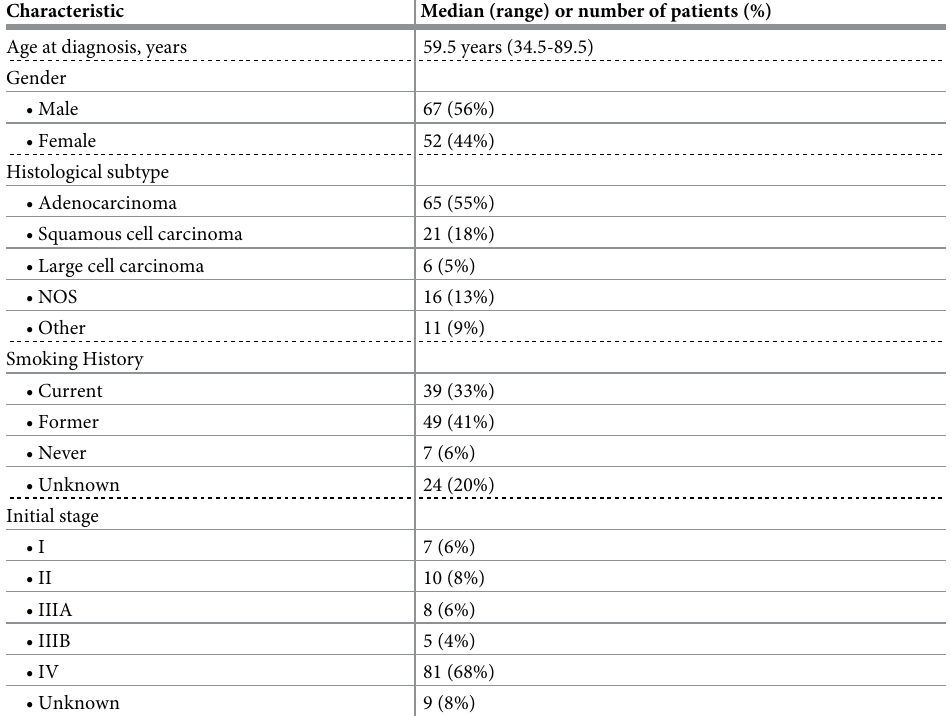
Table 1. Patient